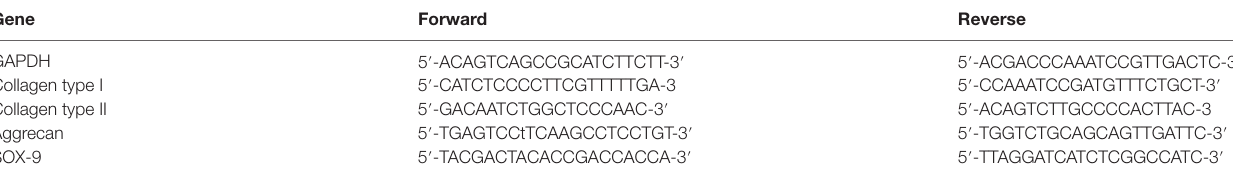
TaBle 1 | Primers used to evaluate the gene expression of human articular chondrocytes by real-time quantitative Pcr. gene Forward reverse